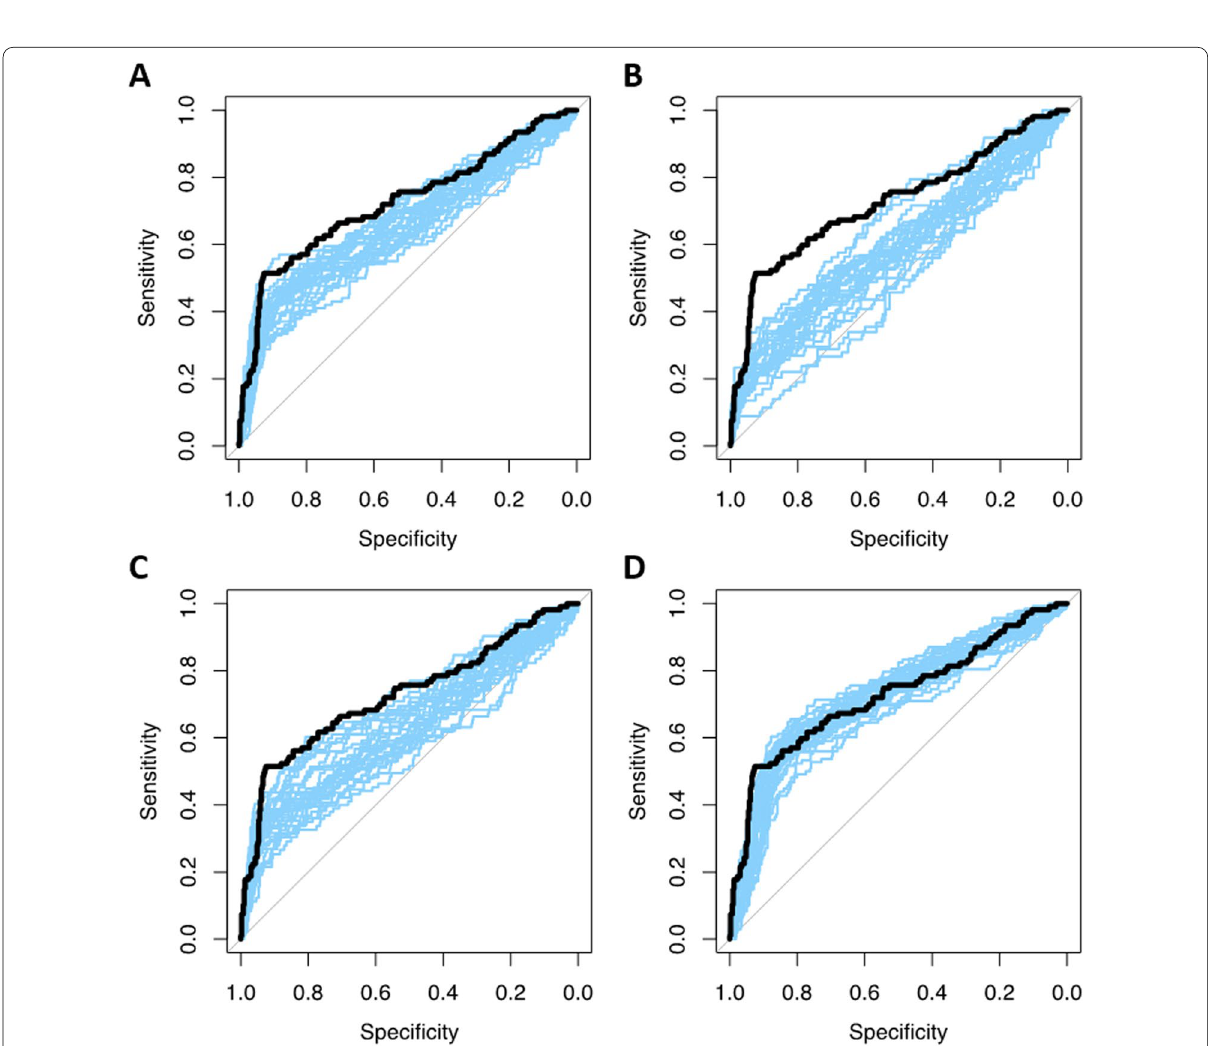
Fig. 2 AUCs of 25 repeats of external simulated datasets with different distributions of Ann Arbor stage in blue with the simulated true expected AUC in black A simulated dataset with 33% Stage 2, 33% Stage 3 and 34% stage 4 patients, B simulated dataset with Stage 2 patients, C simulated dataset with Stage 3 patients, D Simulated dataset with stage 4